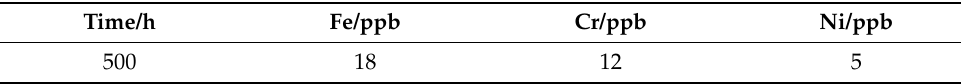
Table 2. The content of cations in the aqueous solution in this work (ppb). Time/h